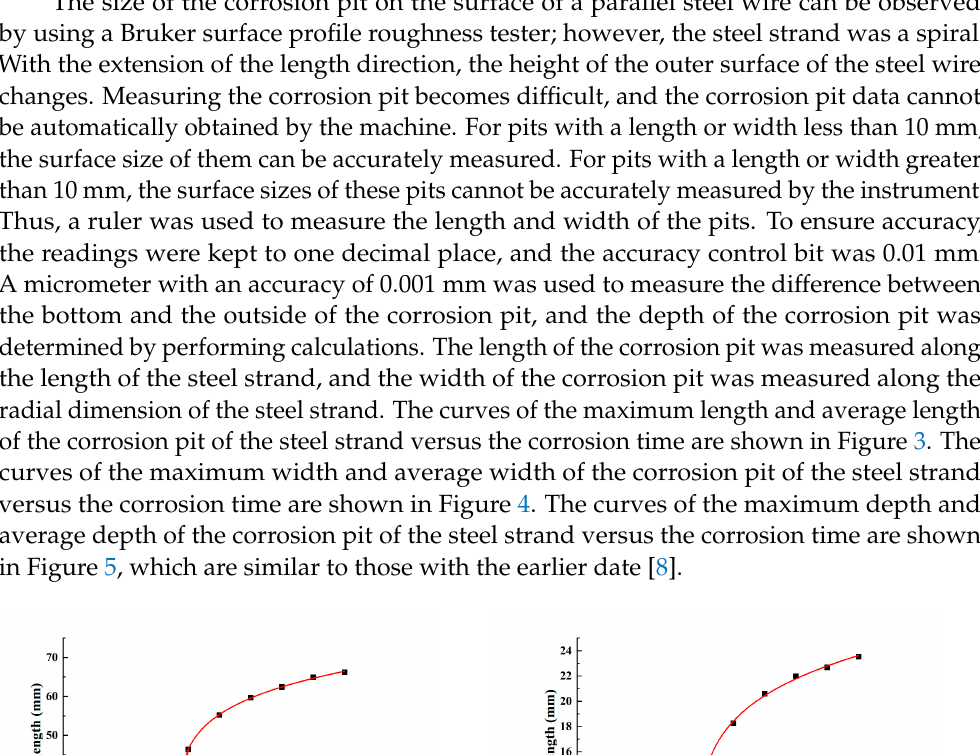
>  Figure 4. Time-varying fitting curve of the corrosion pit width.